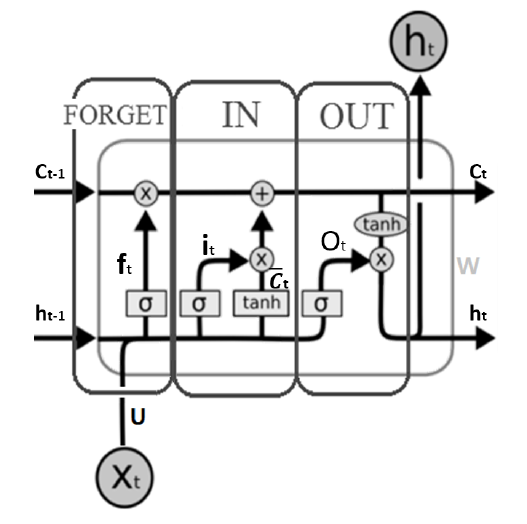
Figure 7. An illustration of LSTM